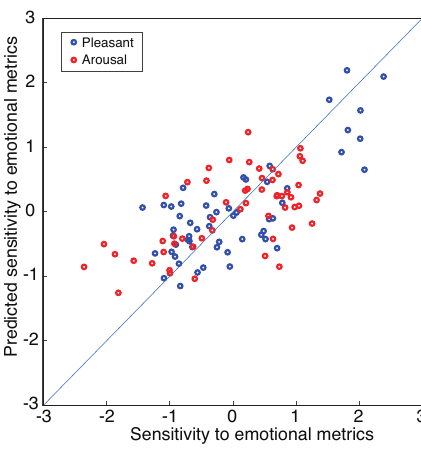
Figure 11. Measured and predicted sensitivities for seven emotional categories (Error bars indicate Standard Errors). 280ms (cid:24) 440ms and 440ms (cid:24) 600ms respectively,